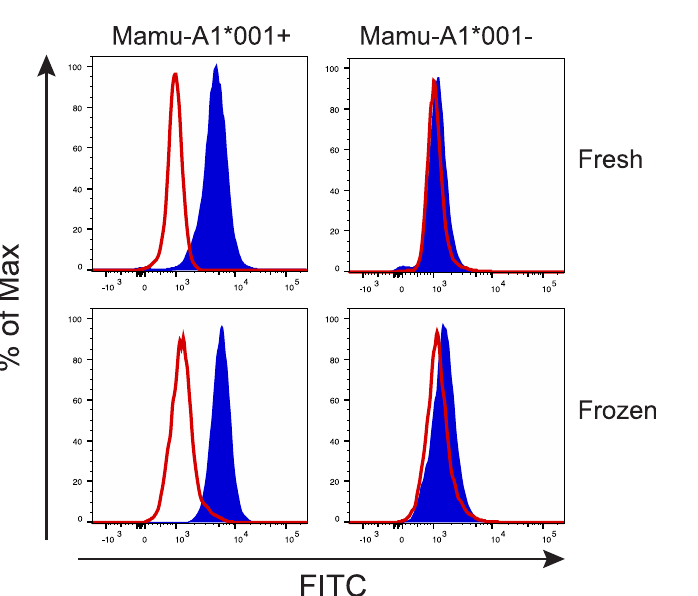
Fig 7. Detection of Mamu-A1 * 001-positive animals using whole blood and P12. Fresh or frozen whole blood from Mamu-A1 * 001-positiveand Mamu-A1 * 001-negativemacaqueswere stained with P12 (blue traces) or non-specificmouse Ig (red traces). Red blood cells were lysed, cell-boundP12 was detected with anti-HA FITC and cell-boundcontrol antibody was detected with anti-mouse Ig FITC. Representative data from the four animalsare